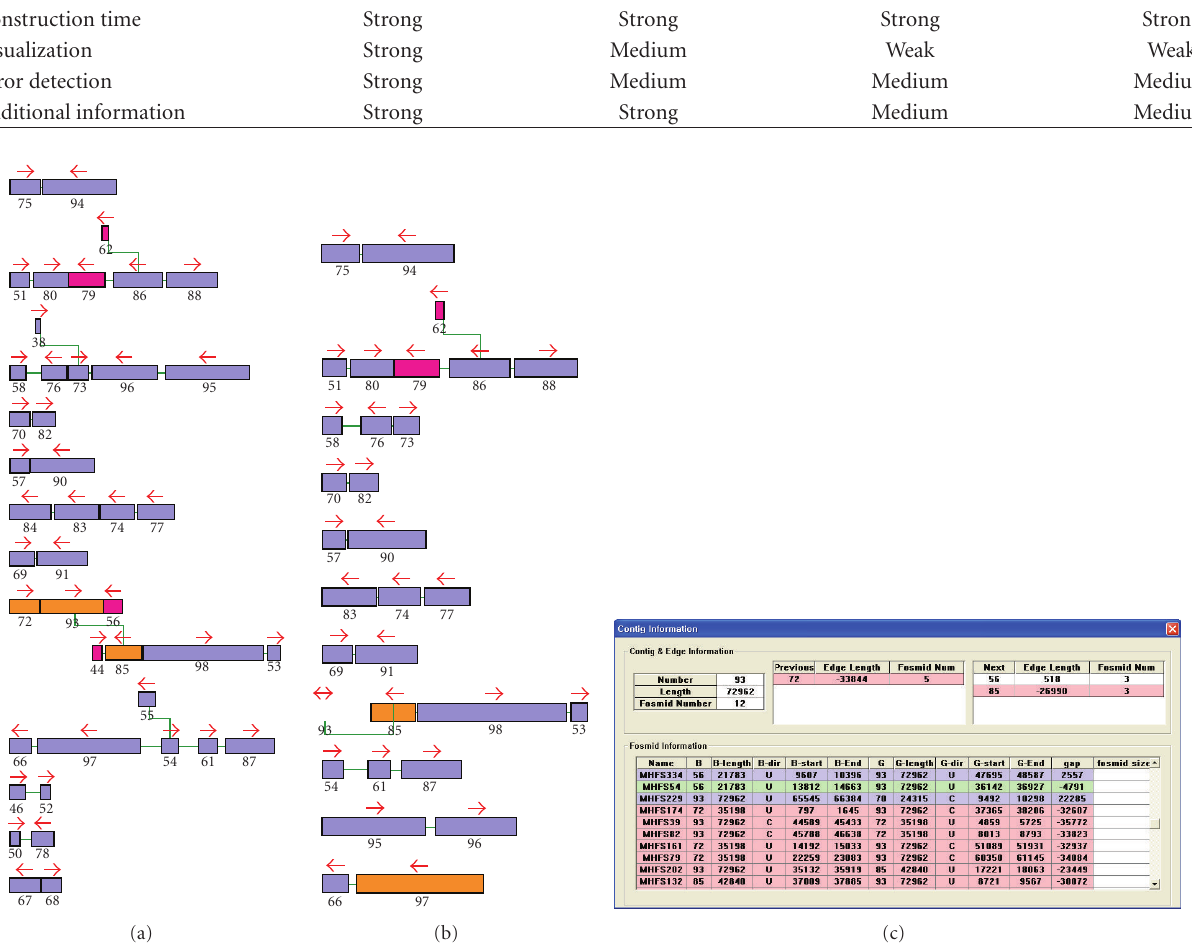
Figure 6: An example of the detection of mis-assembled contigs. (a): Sca ff olds for MH1 at linking level 2; (b): sca ff olds for MH1 at linking level 3; (c): information on contig